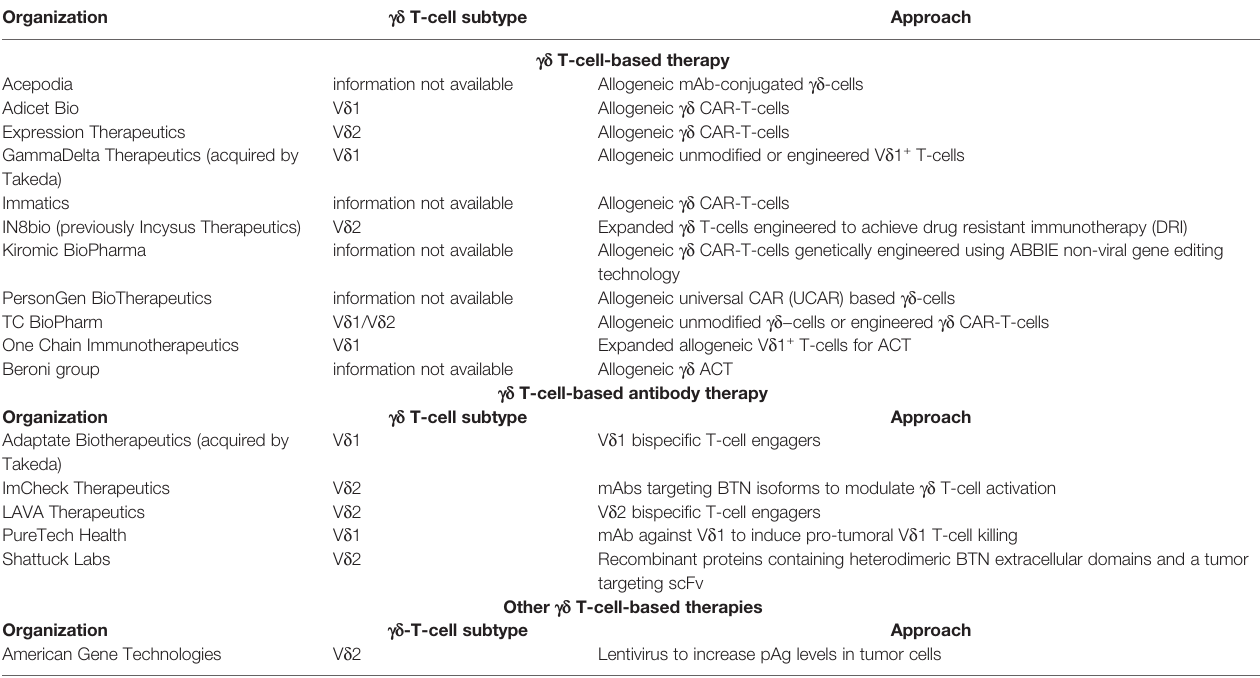
TABLE 2 | Companies developing gd T-cell-based or gd T-cell-engaging